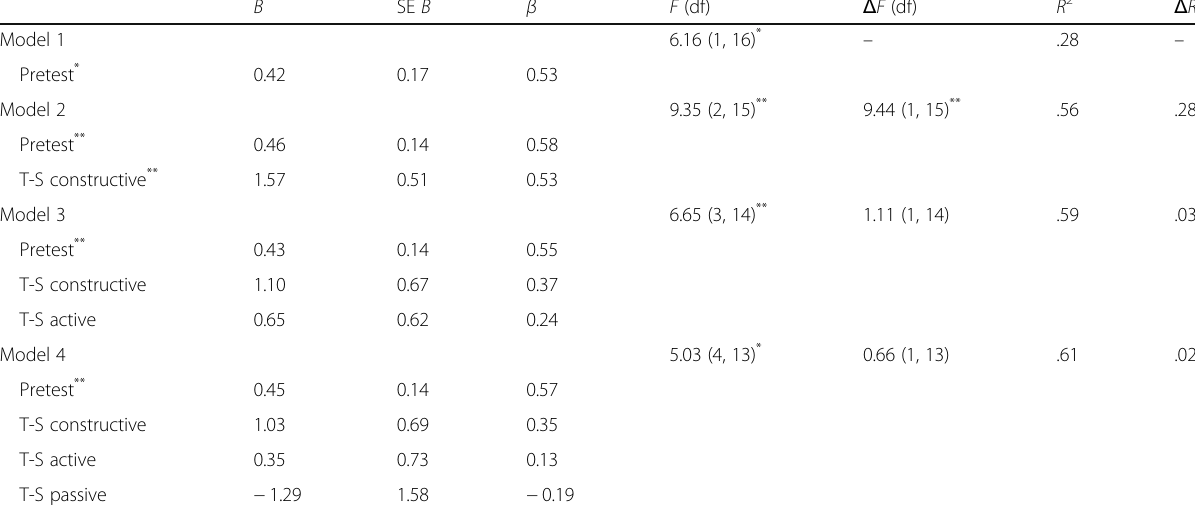
Table 8 Regression models predicting transfer scores from proportions of teacher-student exchanges B SE B β F